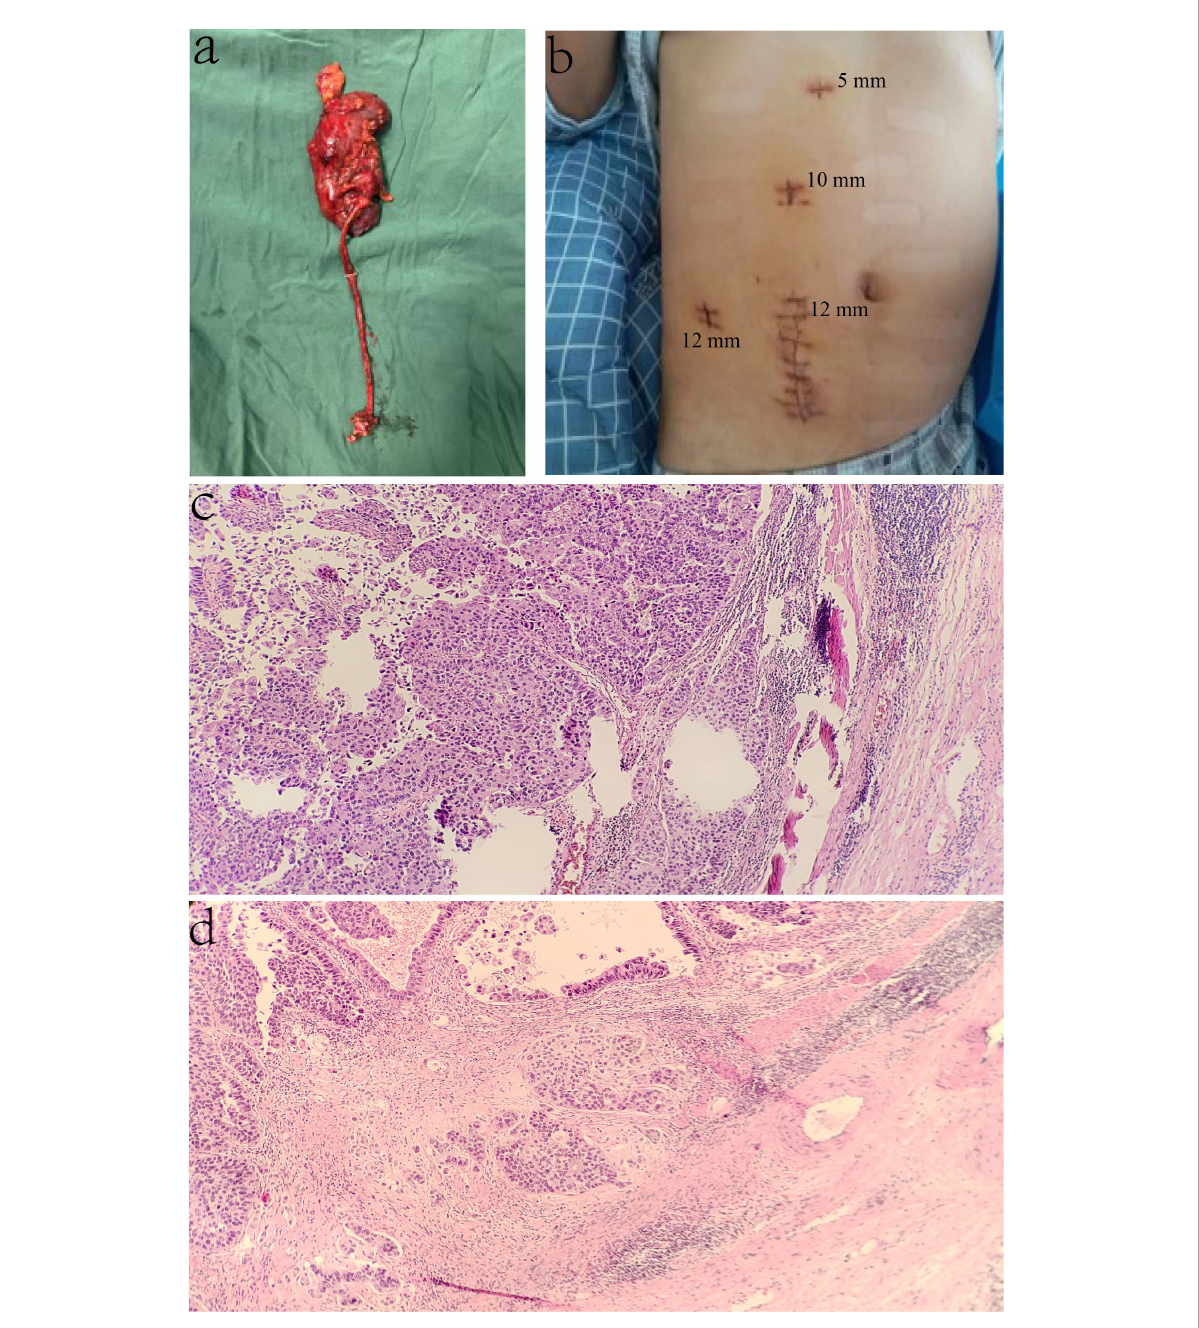
causes the ureter to be compressed when it passes through